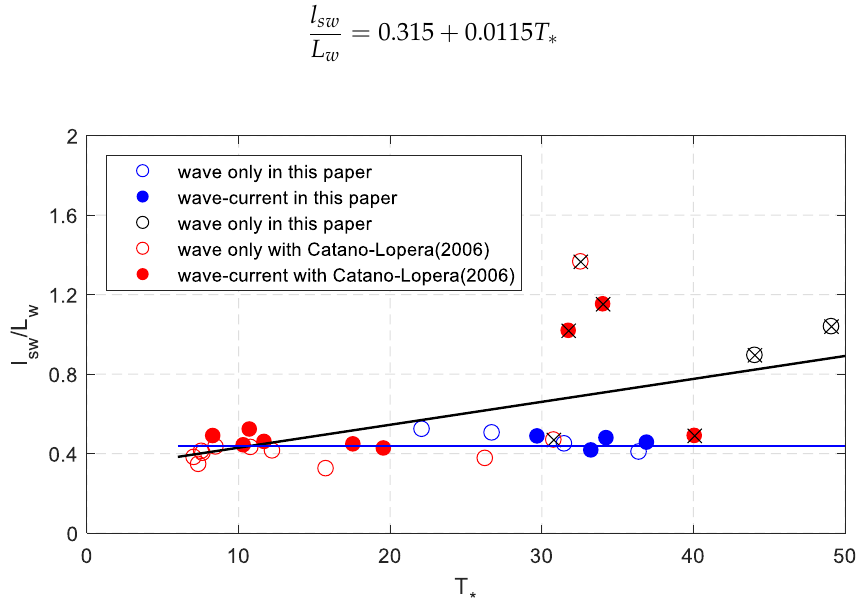
Figure 10. The relationship between the measured dimensionless sand wave length and dimensionless shear